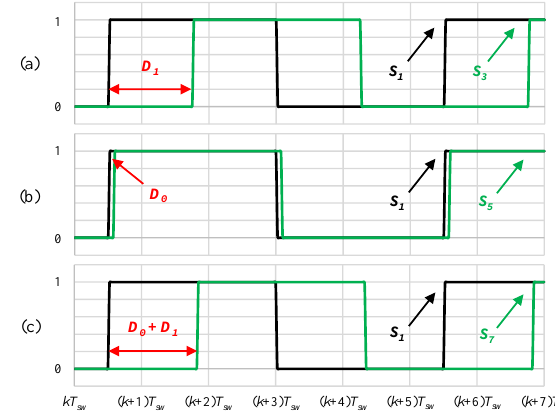
Figure 11. Triggering gate signals using DPS modulation: (a) S 1 , S 3 ; (b) S 1 , S 5 ; (c) S 1 , S 7 .